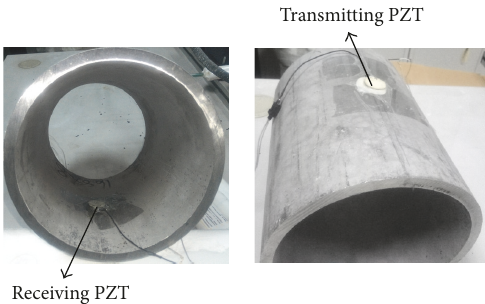
Figure 6: The physical ultrasonic vibration energy transmission channel through a cylindrical metal pipe.